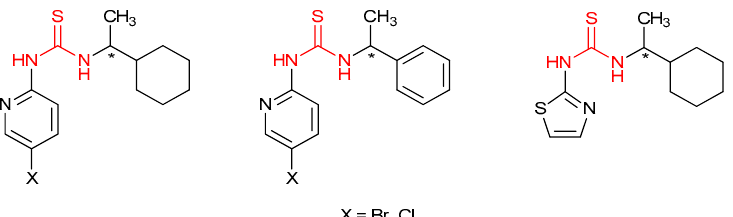
Figure 42. A new set of chiral halopyridyl and thiazolyl thioureas studied as antiproliferative agents [381].